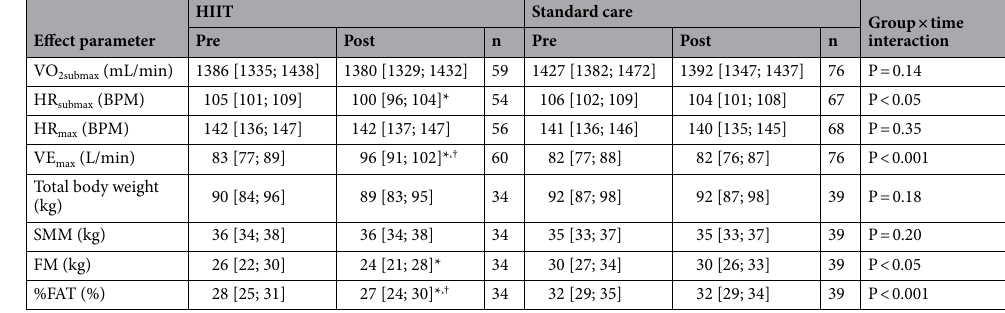
Table 2. Cardiovascular adaptions and body composition. Values are presented as means (with 95% confidence intervals) from a linear mixed-model with group, time and group × time interaction as fixed factors. body fat mass, %FAT body fat percentage. If a significant effect of group × time interaction existed, the result of the post hoc analysis is indicated by *P < 0.001 compared with pre-intervention and † P < 0.05 compared to standard care.